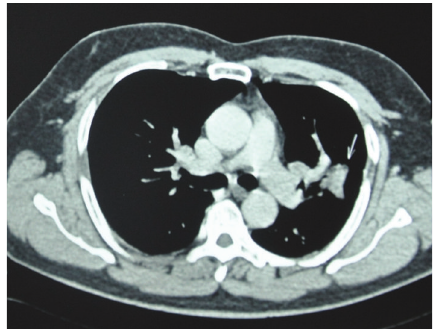
Figure 3: CT scan of the lung (transverse section) showing well- defined nodular lesion measuring 4.1∗3.6 cms in the left upper lobe with spiky margins.